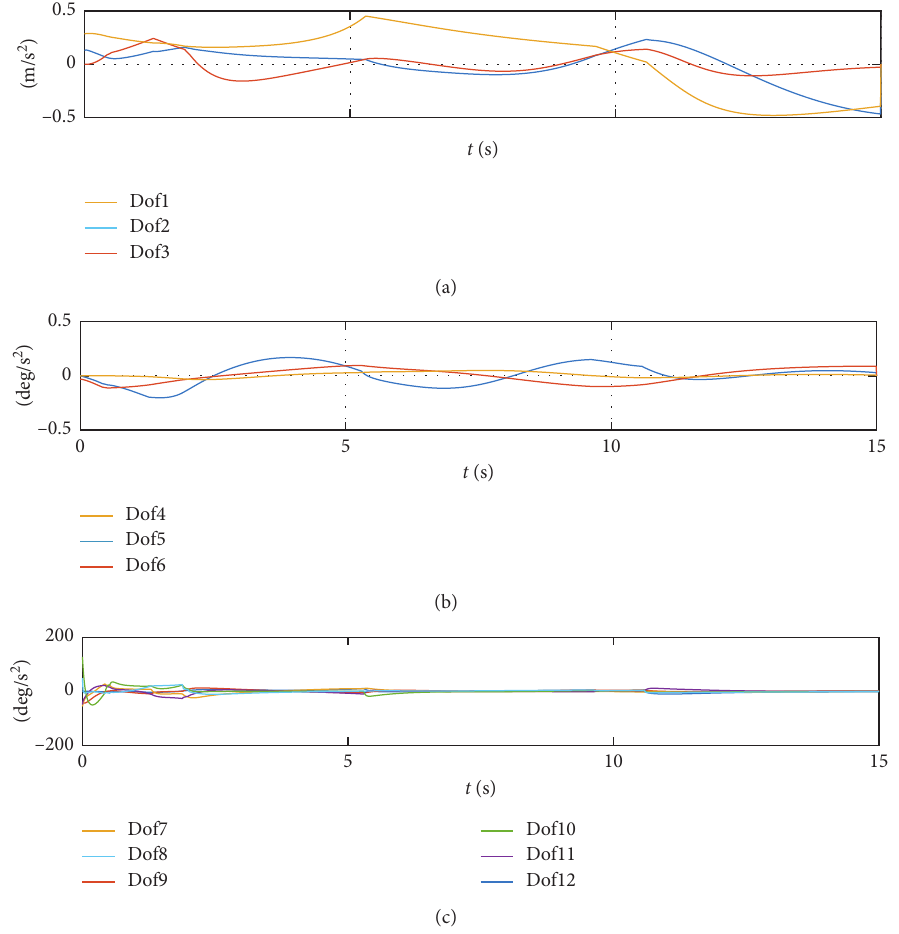
Figure 13: Acceleration variation process of the UVMS driven by the proposed method. (a) Vehicle accelerations. (b) Vehicle angular accelerations. (c) Joint